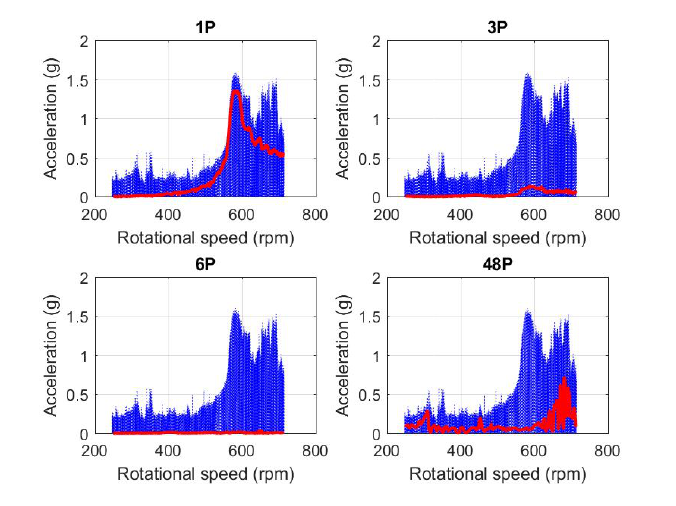
Figure 10. Revolution per minute/acceleration plot for the individual Y direction tower